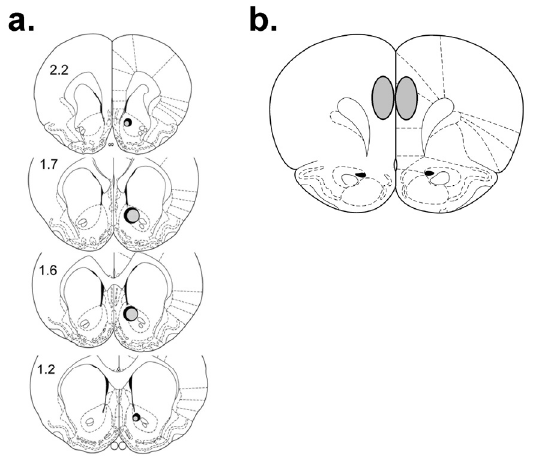
Figure 6. Histological analysis of intra-NAc fluosphere injection sites ( a ) and the region of plPFC that comprised the largest density of retrogradely-traced neurons, and was therefore analyzed ( b ). Numerals indicate mm from bregma. The largest (solid) and smallest (shaded) bolus sizes of all animals included in analysis are indicated. All injection sites were within ±10% in